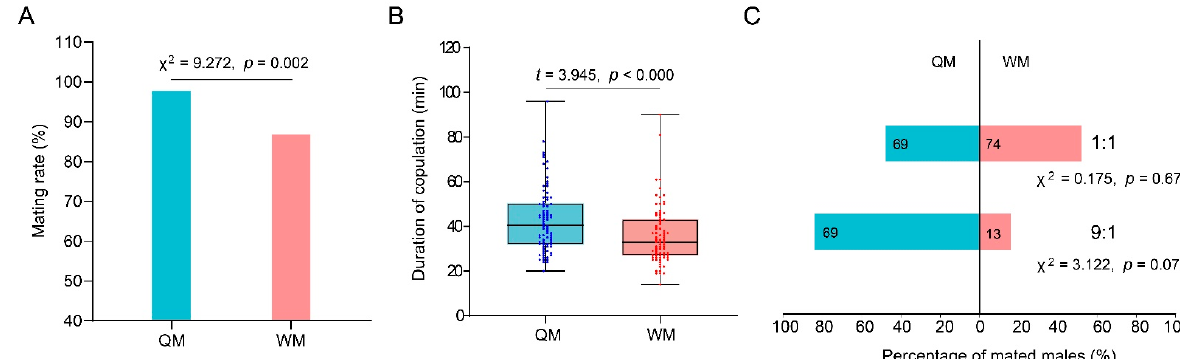
Figure 3. Comparison of mating ability and competitive copulation between the QMs and the WMs. ( A ) The mating rate of the QMs and the WMs based on the proportion of mated queens; ( B ) the duration of copulation contributed by QMs and WMs ( n = 82, 79). The scatter plots represent the data values, and the upper and lower edge lines of the box represent the upper quartile and the lower quartile; ( C ) the percentage of mated QMs and WMs in competitive copulations in the 1:1 and 9:1 ratio experiments, respectively. The number in each bar represents the number of males that successfully mated with a queen. The Pearson chi-square test was used to analyze the differences in the mating rate of the QM and the WM. The t-test was used to analyze whether significant differences existed in mating duration. The one-sample chi-square test was used to analyze whether significant differences existed between the ratio of mated the QMs and the WMs and the theory proportion of the QMs and the WMs.